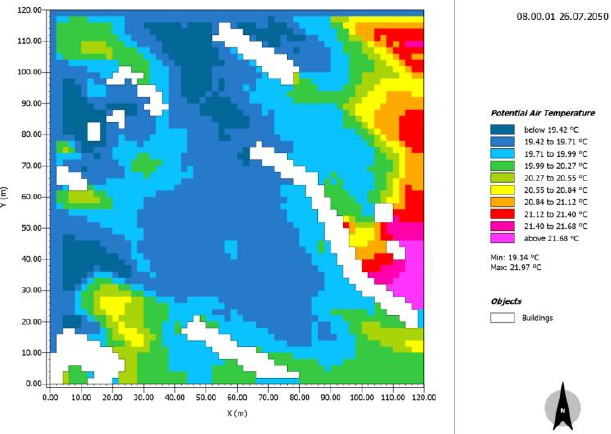
Figure 8. T3 ″ simulation for 8:00 am, 26 July 2020 (image generated by ENVI-met). Figure 8. T3 (cid:48)(cid:48) simulation for 8:00 a.m., 26 July 2020 (image generated by